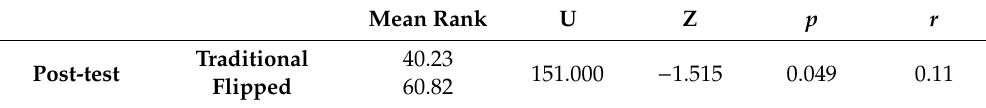
Table 4. Mann–Whitney U test for learning achievement dimension.